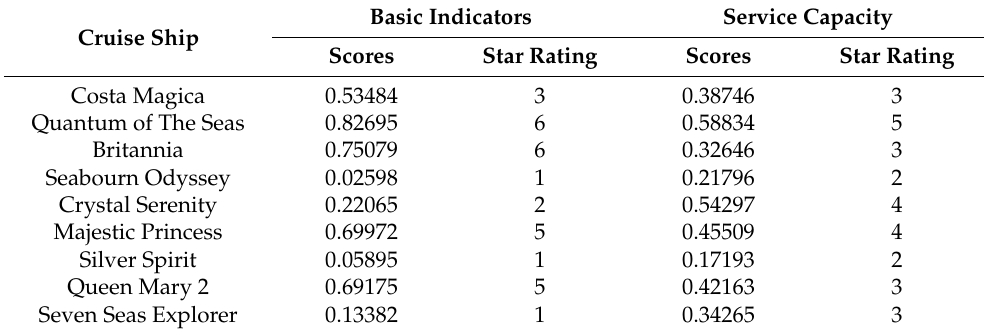
Table 8. The evaluation results and rankings of basic indicators and service capacity for cruise